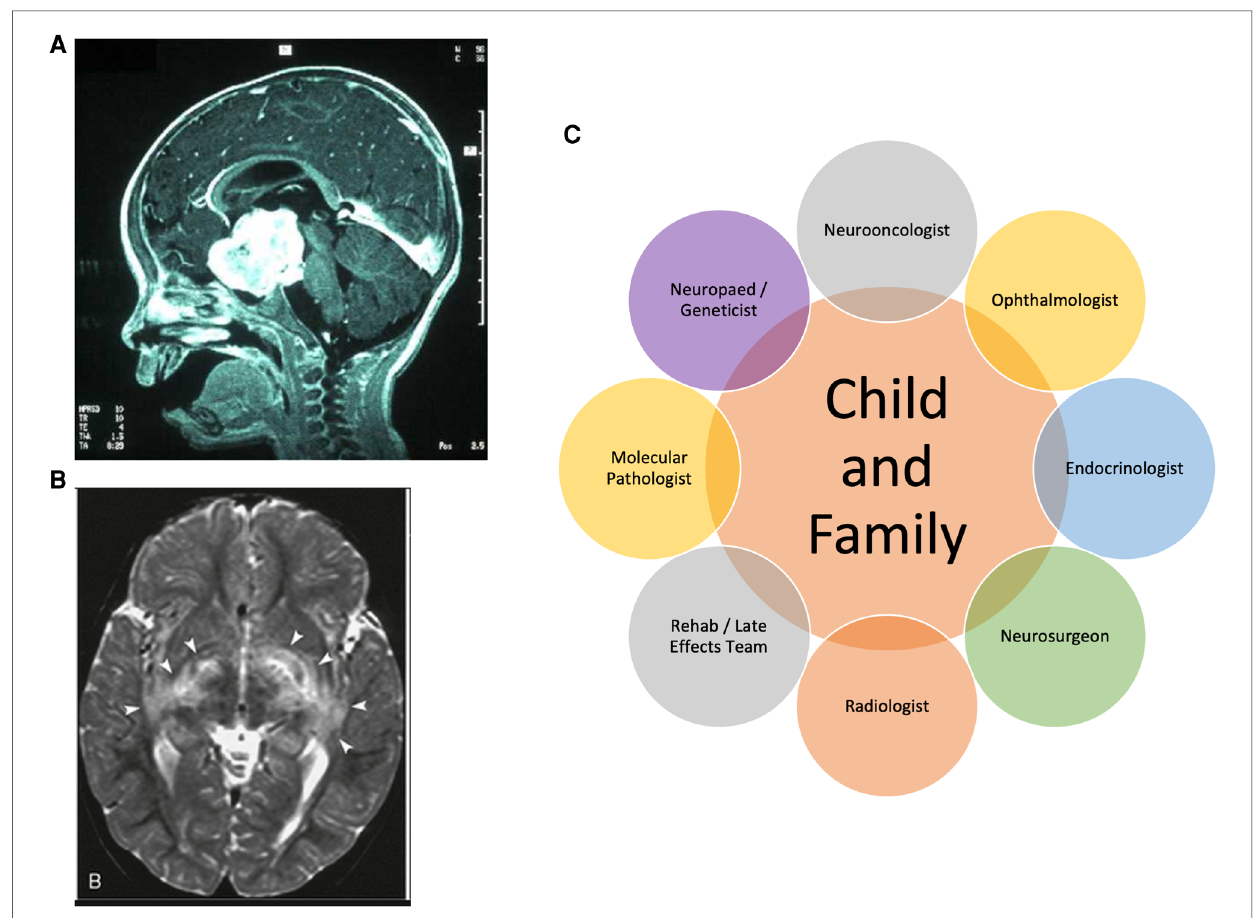
FIGURE 2 MRI scan of typical ( A ) sporadic hypothalamic and ( B ) multi-focal NF1 OPHG involving posterior radiations; ( C ) clinical specialisms involved in the OPHG multidisciplinary